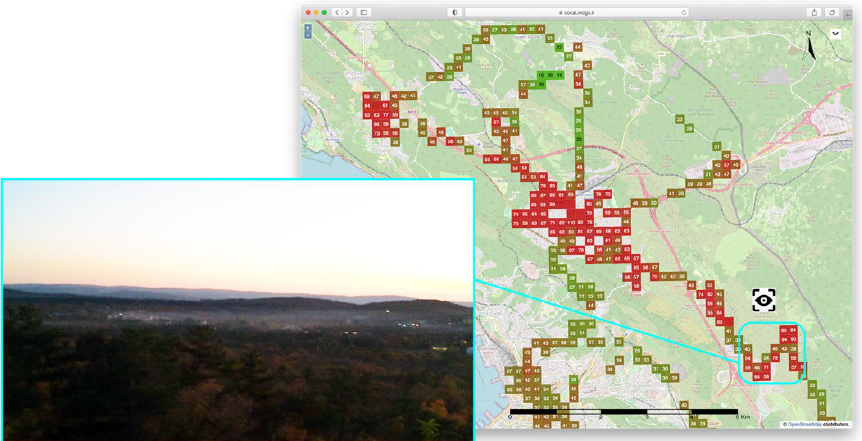
Figure 8. Map of the distribution of PM between 5 p.m. and 9 p.m. in the area of Padriciano/Padriče and Gropada/Grpeč (right). On the left, a photo taken at 6 p.m. towards the South, from the position identified on the map with the icon of an eye. The photo captures the emissions in the area highlighted in light blue on the map.